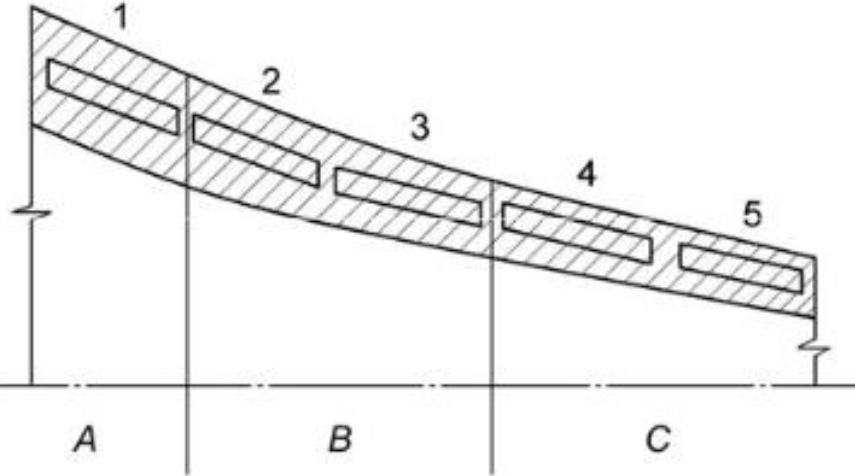
Figure 1. A schematic of the cutoff of specimens from the pipe billet: 1–5, sample number; A, upsetting zone, B, reduction zone, C, calibration zone.